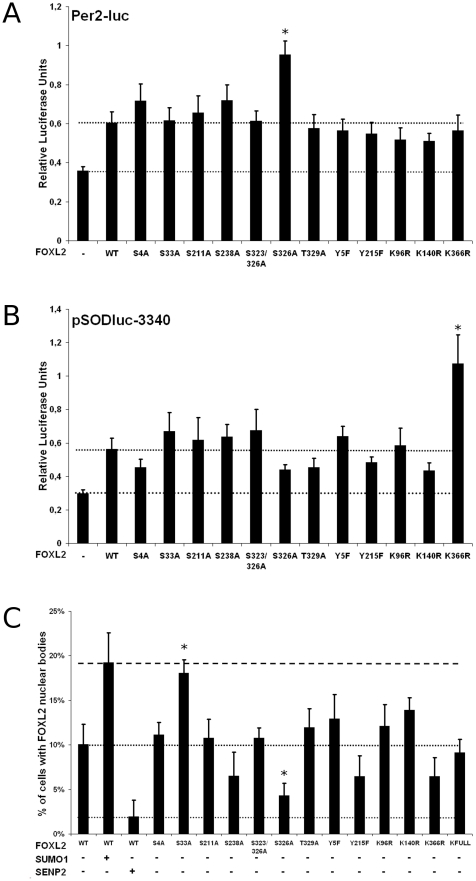
Transactivation ability and localisation rate to PML NBs of non-modifiable mutants.A and B) Luciferase assays in KGN cells transfected with Per2-luc and pSODluc-3340 (40 ng/well), respectively, with or without overexpression of wild-type FOXL2 or various FOXL2 alleles (20 ng/well), each one corresponding to a substitution of a potentially modified residue by an amino-acid simulating the non-modified residue. Each value is representative of six biological replicates. Error bars represent the SEM. Statistical significance in Student t-tests, compared to FOXL2-WT: *: p<0.05. Hyperactivities of FOXL2-S326A on Per2-luc and FOXL2-K366R on pSODluc-3340 compared to FOXL2-WT were seen only in one experiment out of four. C) Quantification of cells presenting subnuclear structures in COS-7 expressing wild-type FOXL2-GFP with or without overexpression of SUMO1 or SENP2, or the same FOXL2-GFP alleles as above. At least 200 GFP-positive cells were scanned per condition (in groups of at least 50 cells to estimate the standard deviations). Error bar: SEM. Statistical significance in Student t-tests, compared to FOXL2-WT: *: p<0.05.